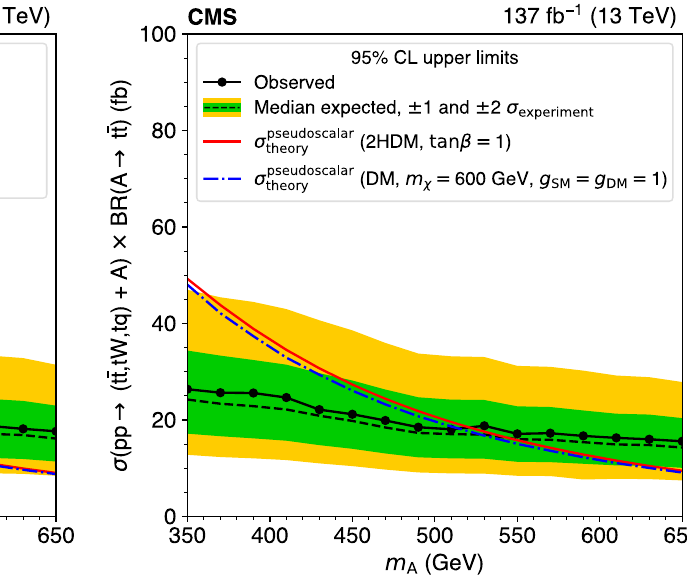
Fig. 7 Theobserved(points)andexpected(dashedline)95%CLupper limits on the cross section times branching fraction to tt for the produc- tion of a new heavy scalar H (left) and pseudoscalar A (right), as a function of mass. The inner and outer bands around the expected limits